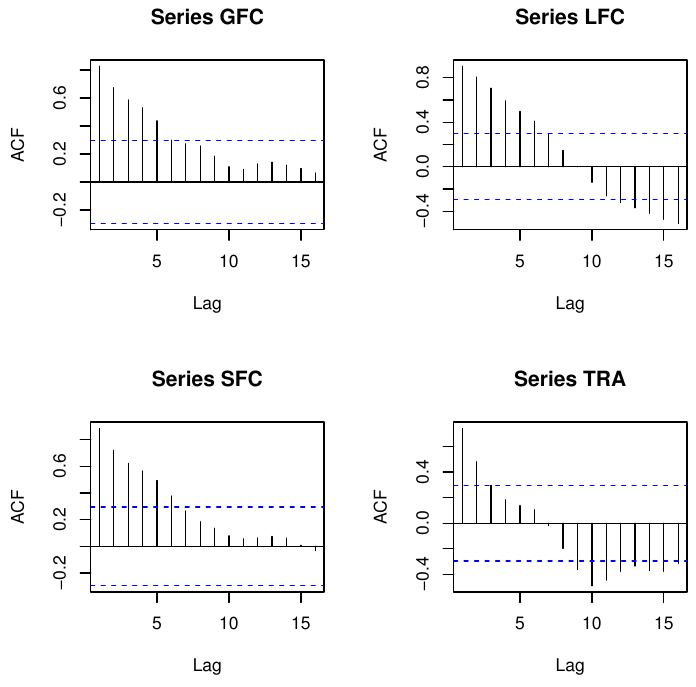
Figure 2. Autocorrelation function of CO 2 emissions data.